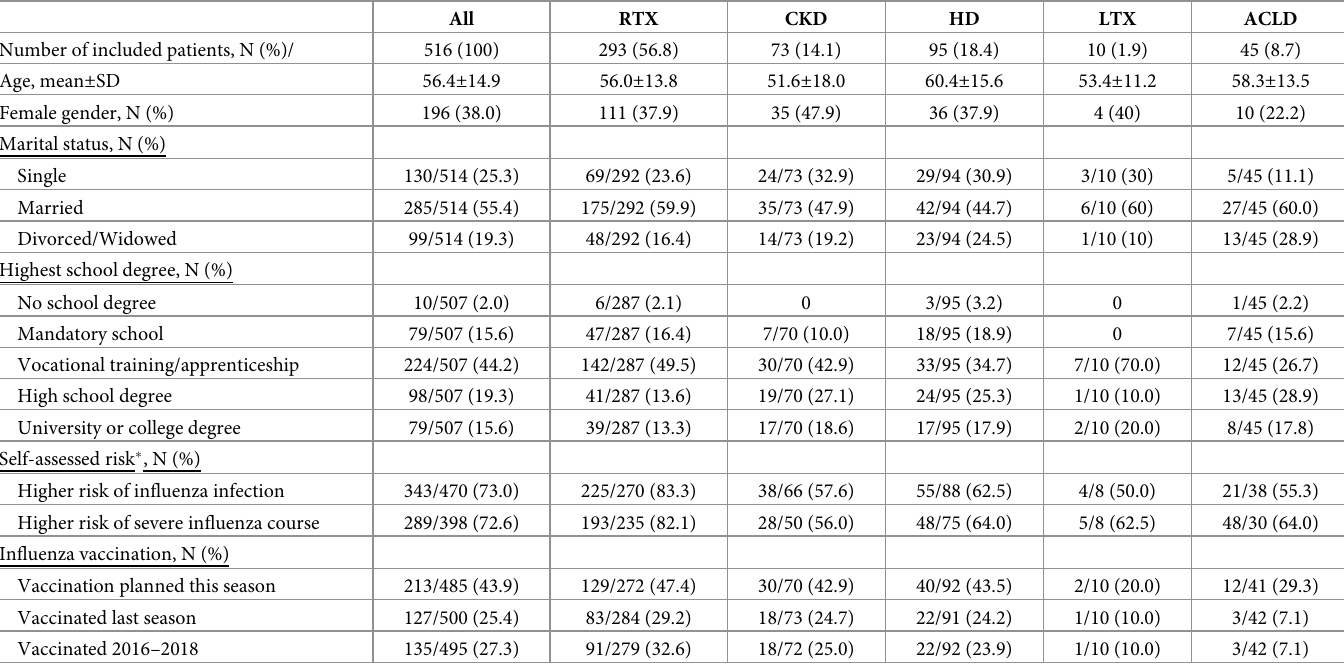
Table 1. Demographic parameters and influenza vaccination rates in all patient groups.